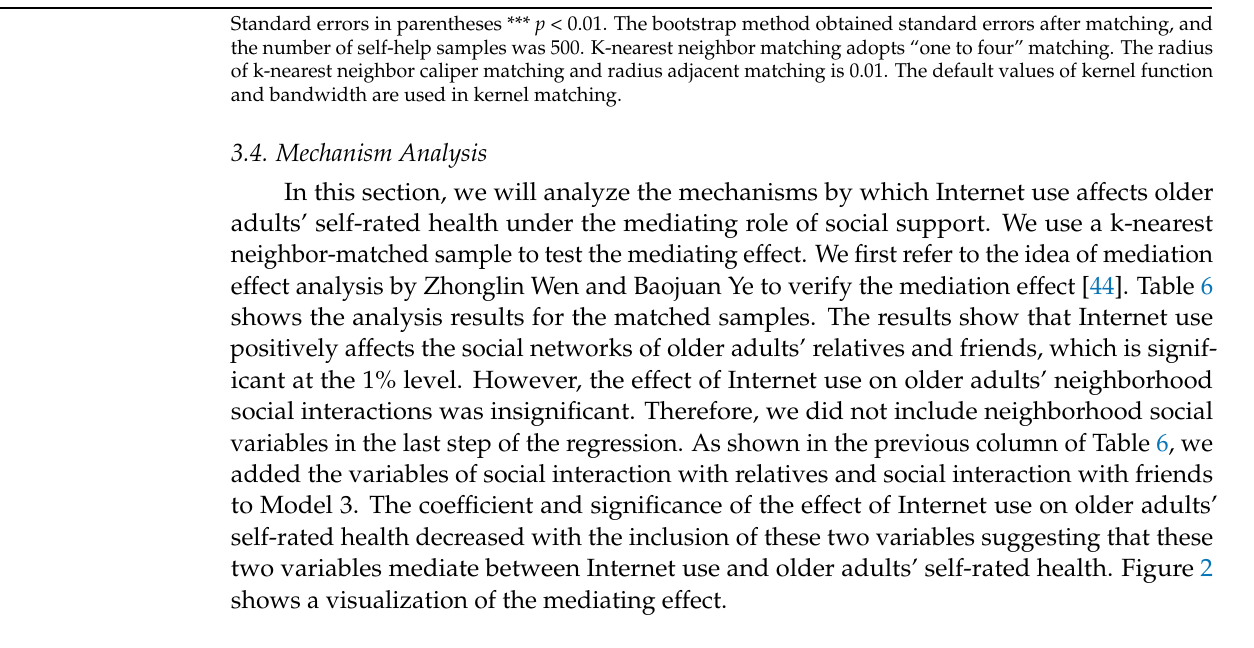
Table 6. The mediating effect of social